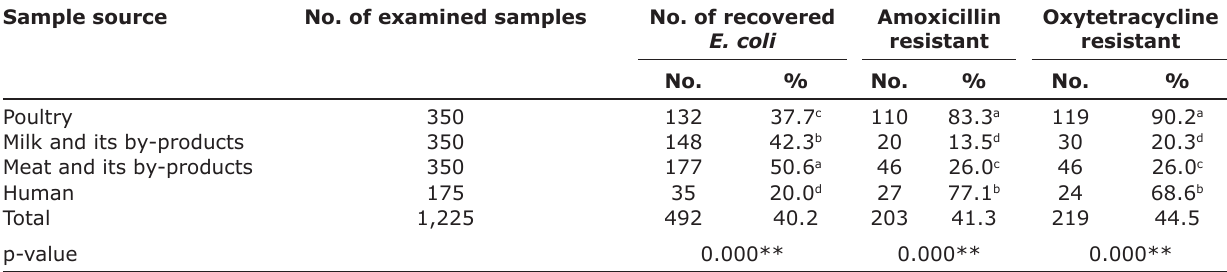
Table -13: Prevalence rates of amoxicillin- and oxytetracycline-resistant E. coli from different sources. Sample source